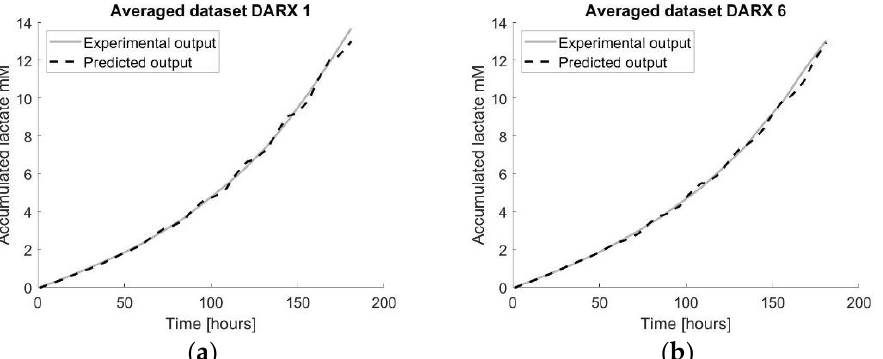
Figure 9. Visualisation of the forecast models using multiple datasets by applying a transfer function on the averaged dataset. The number in the title refers to the number of the tissue flask used as the test set. ( a ) visualizes the prediction model developed using the DARX transfer function model on the average of the whole training set with TF1 as the test set. ( b ) visualizes the prediction model developed using the DARX transfer function model on the average of the whole training set with TF6 as the test